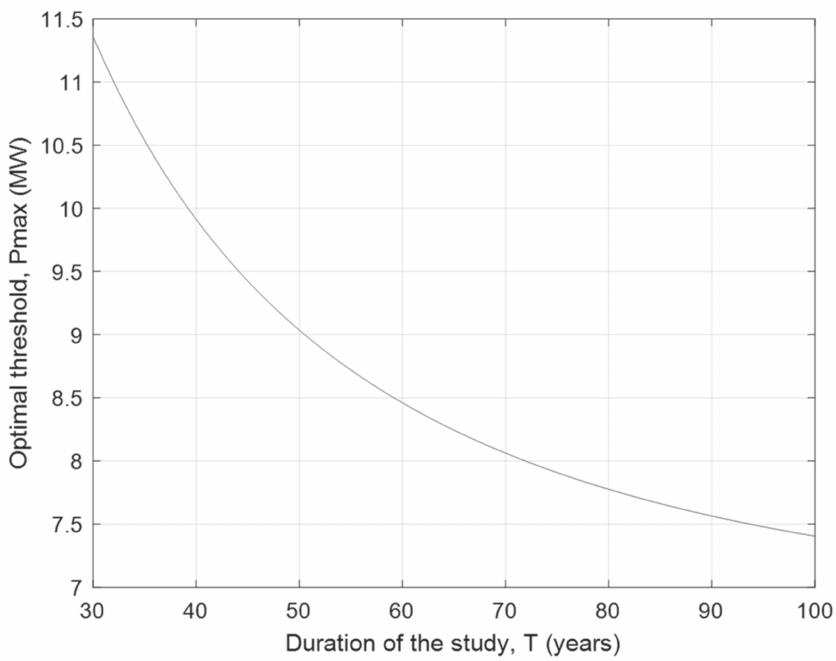
Figure 10. Optimal threshold as a function of the duration of the study.